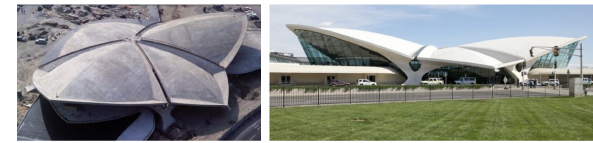
Figure 11: The TWA terminal in New York, by Eero Saarinen (1962)